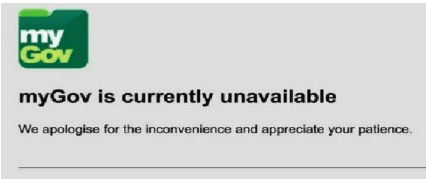
Figure 16: “myGov” online services site is down by DDoS attack